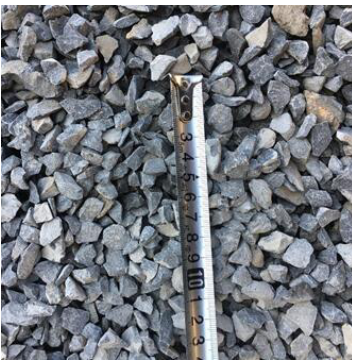
Figure 1. Gravel used in the direct shear test Three biaxial geogrids (SS20, SS30 and SS40) and three triaxial geogrids (TX150, TX160 and TX170) with different tensile properties were used in the study. The tensile strength values of these geogrids for loading in different directions are shown in Table 1. For both biaxial and triaxial geogrids, tensile strength decreases with the direction of tensile load- ing, changing from 0° to 45°, and then increases with the direction, changing from 45° to 90°. This indicates that the tensile strength of geogrids is significantly influenced by the direction of tensile loading, and also shows anisotropic behavior in both types of geogrids, especially for the biaxial geogrids. Table 1. Tensile strength of geogrids for loading in different directions (kN/m).